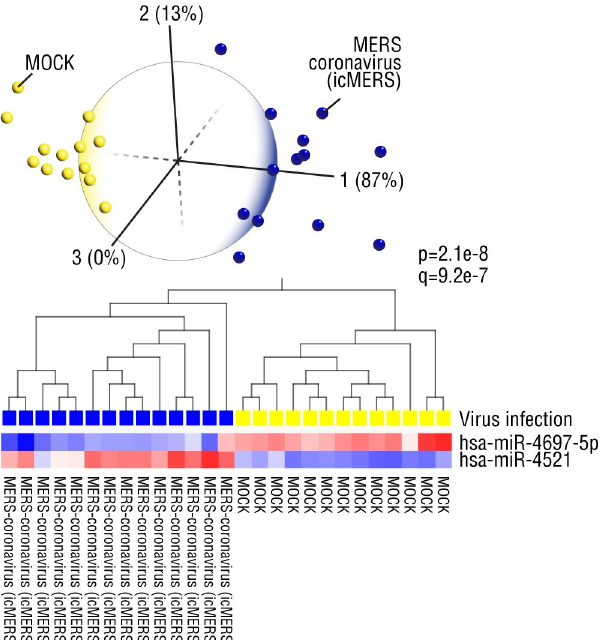
Fig 1. MERS-CoV-induced microRNA (miRNA) expression in primary human airway epithelial cells (GSE81852). Two differentially expressed miRNAs (hsa-miR-4697-5p, hsa-miR-4521) clearly distinguish MERS-coronavirus (icMERS) infected from MOCK infected control cells; over 50% of predicted gene targets of both miRNAs are implicated in pro-viral, antiviral and/or immunomodulatory functions. Expression levels analyzed using principal component and hierarchical clustering